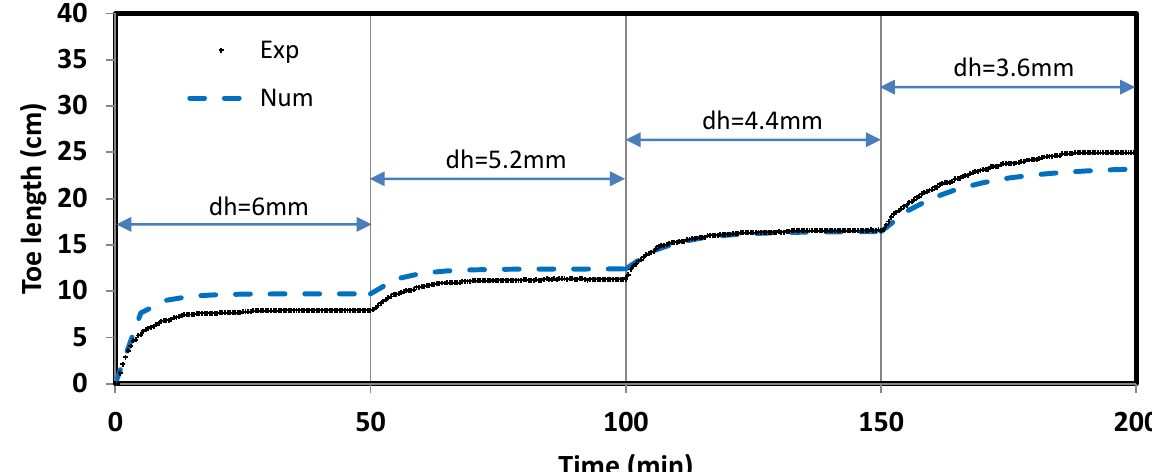
Figure 8. Comparison between the numerical modelling results and the experimental data of the toe length in case 1090 FW.